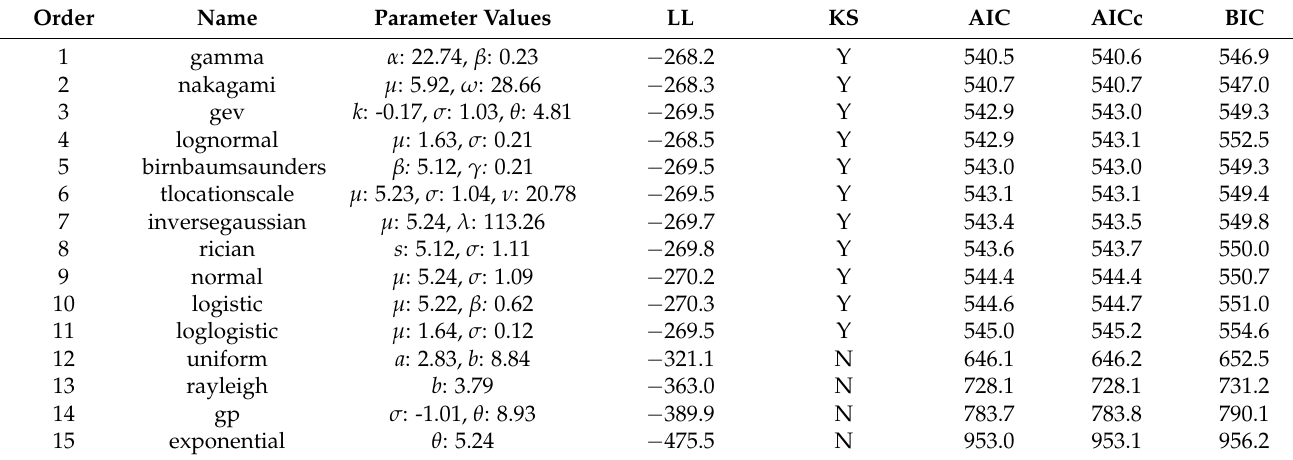
Table A4. Probability Distribution Rankings Using Different Goodness-Of-Fit Tests for Cluster.